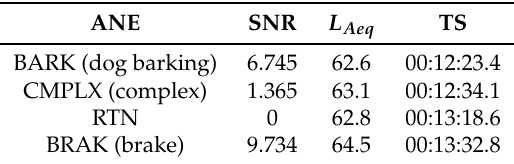
Table 1. Sample of the input data. TS,